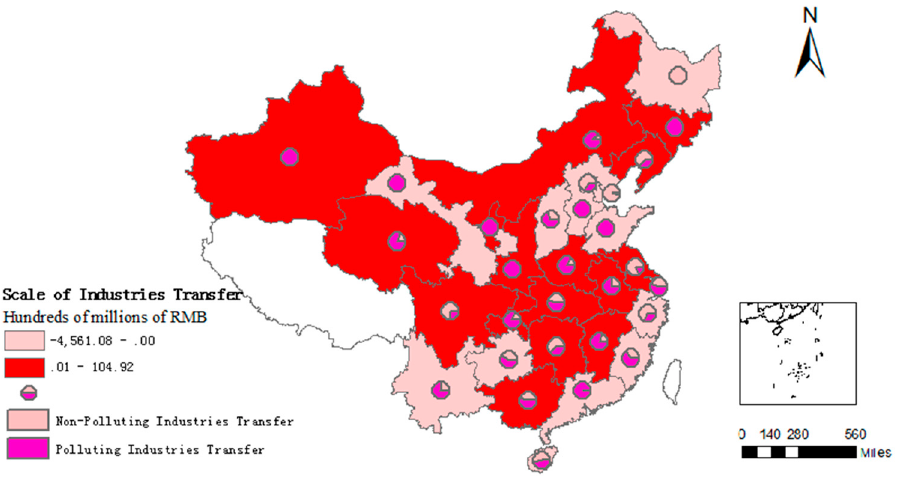
Figure 2. Variation trend of PM 10 average concentration in each province: ( a ) 2008, ( b ) 2013, ( c ) 2014, ( d ) 2016.